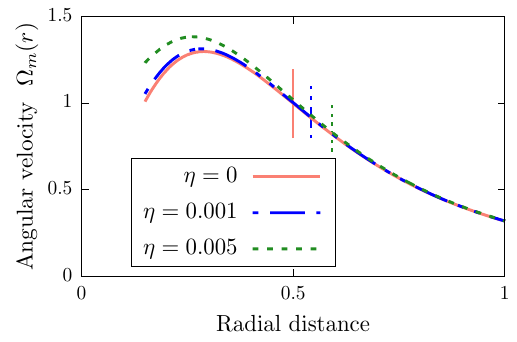
Fig. 2 The above figure demonstrates the variation of the angular velocity (given by the curves) with the radial distance, and the vertical lines denote the locations of the event horizons. For different values of η , it can be shown that the peaks of (cid:11) m always reside inside the event horizon. Therefore, outside the horizon, angular velocity of ZAMO is a monotonically decreasing function of r . We take, a = r s / 2 = 0 . 5